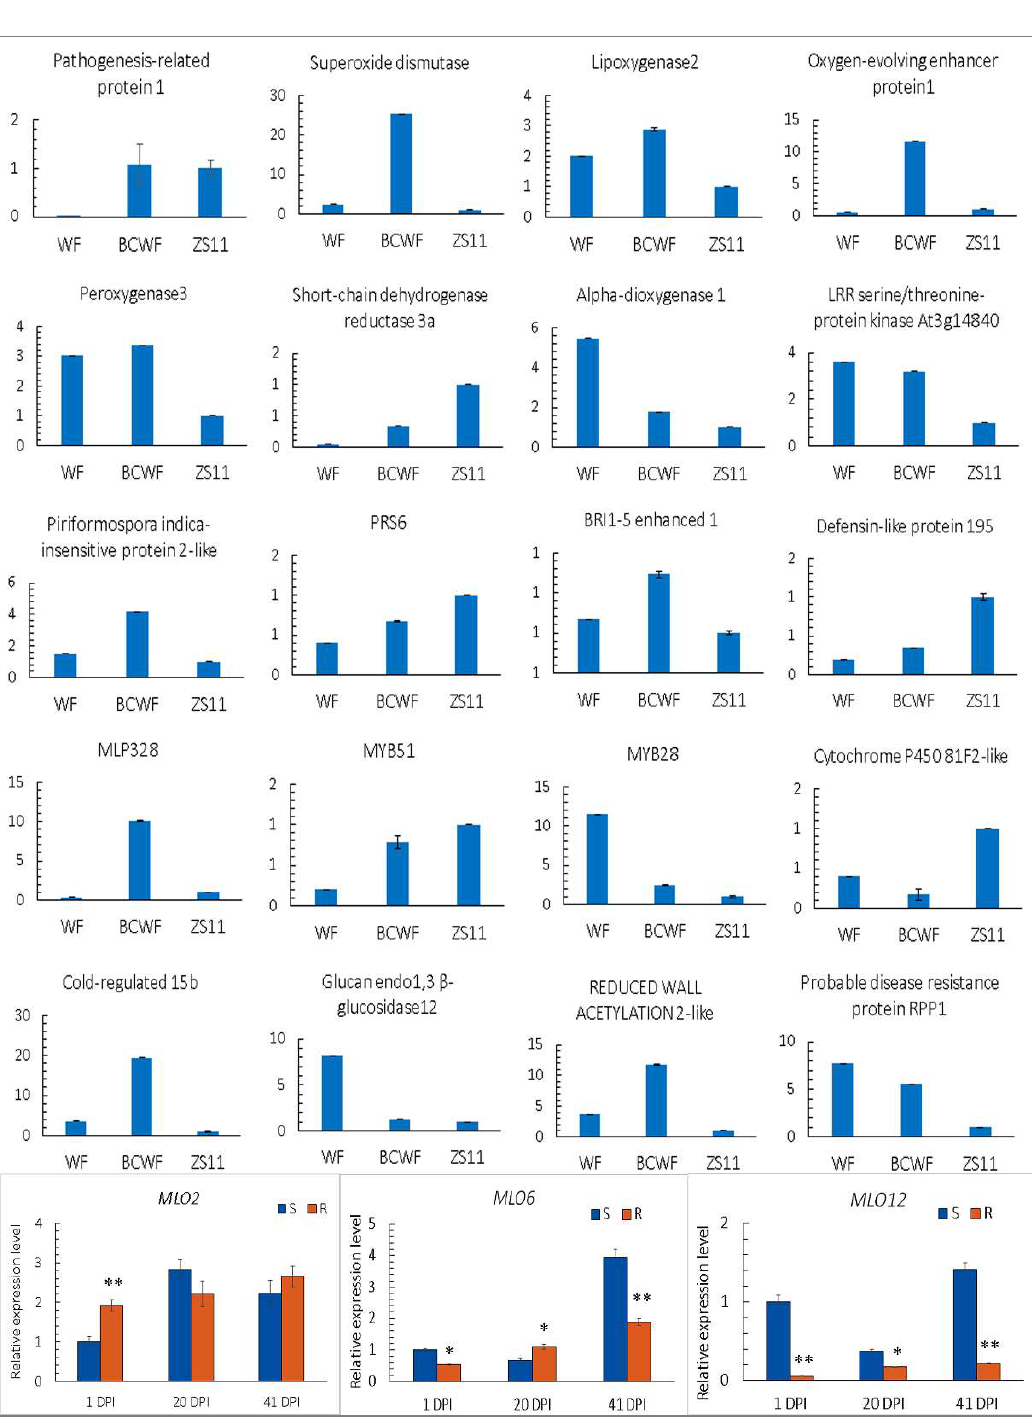
Figure 7. The expression levels of the 20 selected genes detected by qPCR in ‘WF’, ‘BCWF’ and ‘ZS11’ and BnMLO2 , BnMLO6 and BnMLO12 in the S/R plants. Symbols above the bars indicate significant differences at p < 0.05 (*) and p < 0.01 (**).